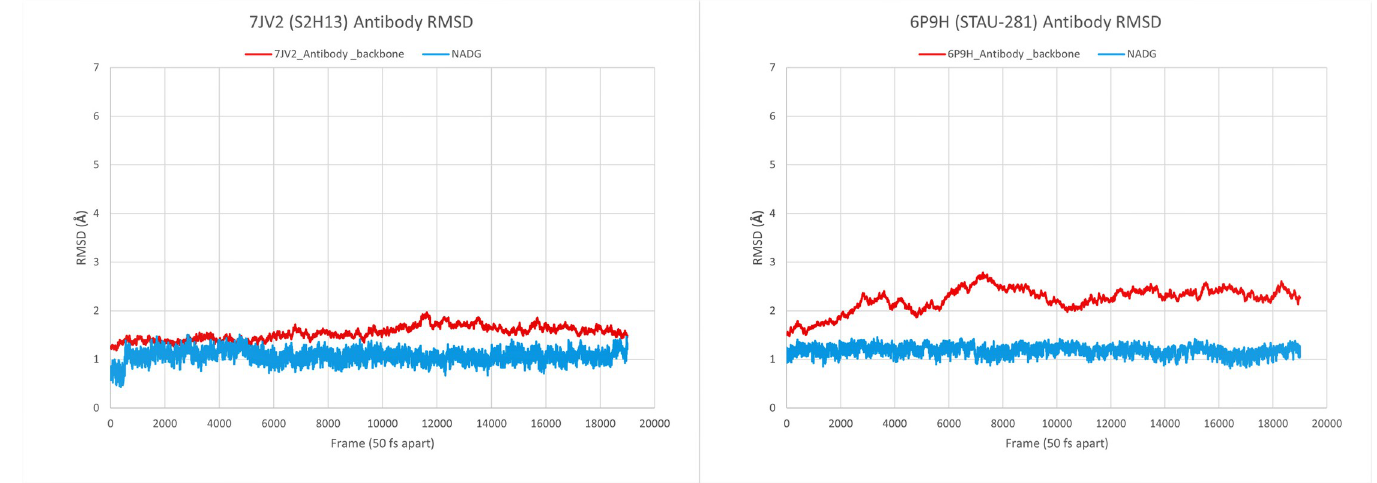
Fig 8. Analysis of molecular dynamics trajectory. Backbone RMSD ( Å ) along the Y-axis and frames (50 fs distance between any 2 frames) along the X-axis for each protein-ligand complex 1.000.000 production runs. Redline indicating protein backbone RMSD and light blue indicating ligand RMSD.